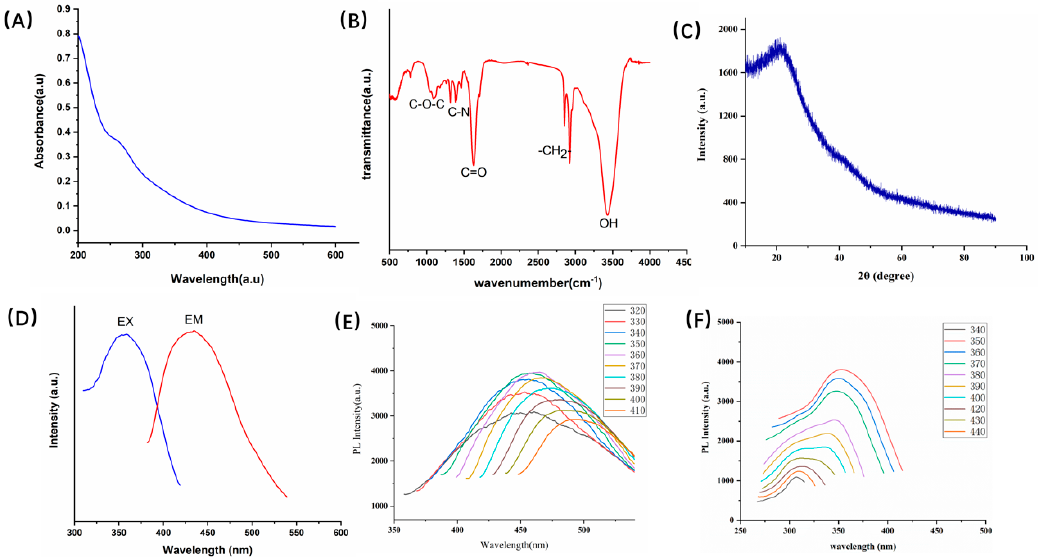
Figure 2. ( A ) Ultraviolet-visible spectrum of Pueraria carbon dots (PLR-CDs). ( B ) Fourier-transform infrared spectrum of PLR-CDs. ( C ) XRD pattern of the PLR-CDs. ( D ) Fluorescence spectra of PLR-CDs, EM represents emission spectra, EX represents excitation spectra. ( E ) Fluorescence spectra of PLR-CDs at di ff erent excitation wavelengths. ( F ) Fluorescence spectra of PLR-CDs at di ff erent excitation wavelengths.